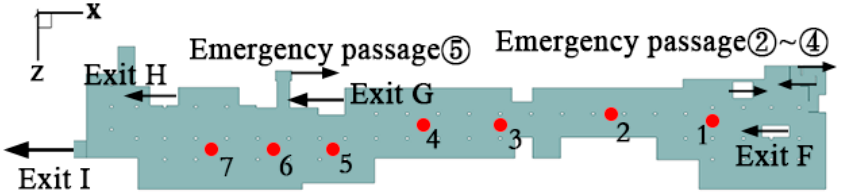
Figure 10. Location map of monitoring points on the property development floor.